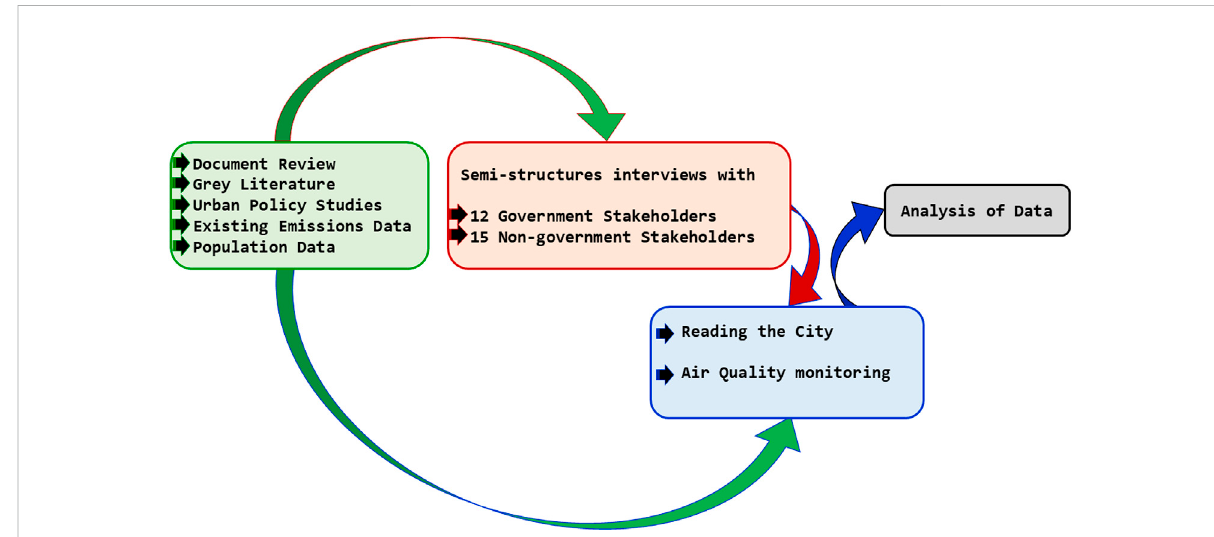
FIGURE 1 Urban diagnostics approach for the assessment of air quality management in